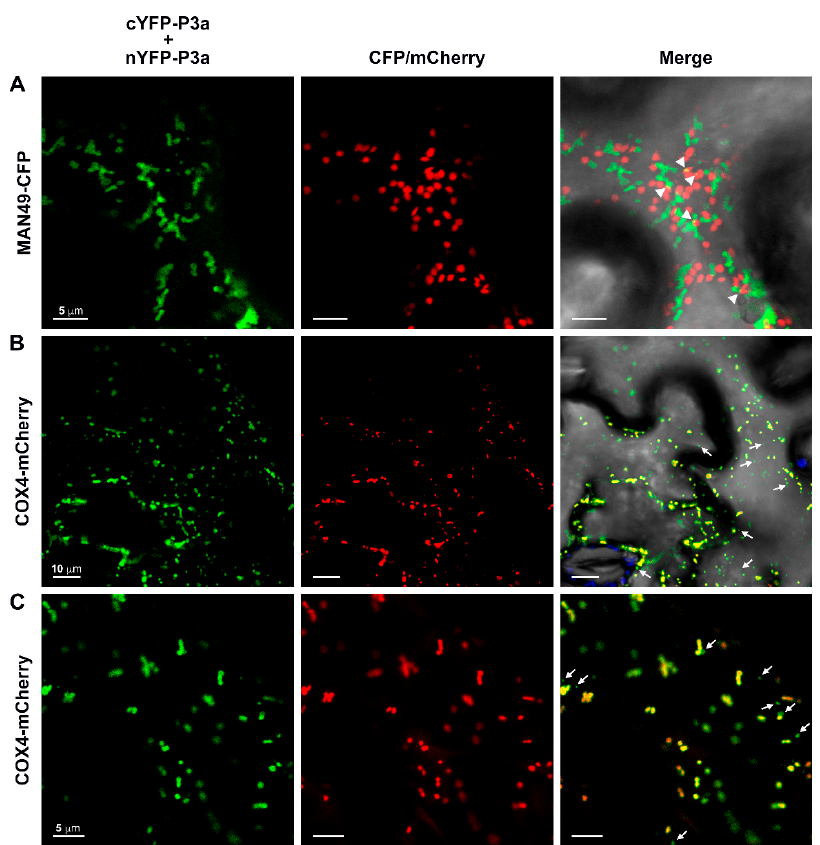
Figure 5. The N-terminally-tagged P3a homodimer co-localizes with mitochondria in N. benthamiana leaf epidermal cells. Panels show single-plane confocal micrographs of plant cells co-expressing the bimolecular fluorescence complementation (BiFC) constructs cYFP-P3a plus nYFP-P3a (fluorescence false-colored green) with ( A ) the cis -Golgi marker MAN49-CFP or ( B , C ) the inner mitochondrial membrane marker COX4-mCherry (red). The overlap of YFP and CFP/mCherry fluorescence with the brightfield overlay image is shown in the column labeled Merge with the co-localization appearing yellow. Chloroplast autofluorescence is falsely colored blue. White arrowheads indicate regions of transient co-localization of the P3a BiFC homodimer and MAN49-CFP. White arrows highlight “vesicle-like” localization of the P3a BiFC homodimer independent of COX4-mCherry fluorescence. Scale bars show the length indicated for each panel.